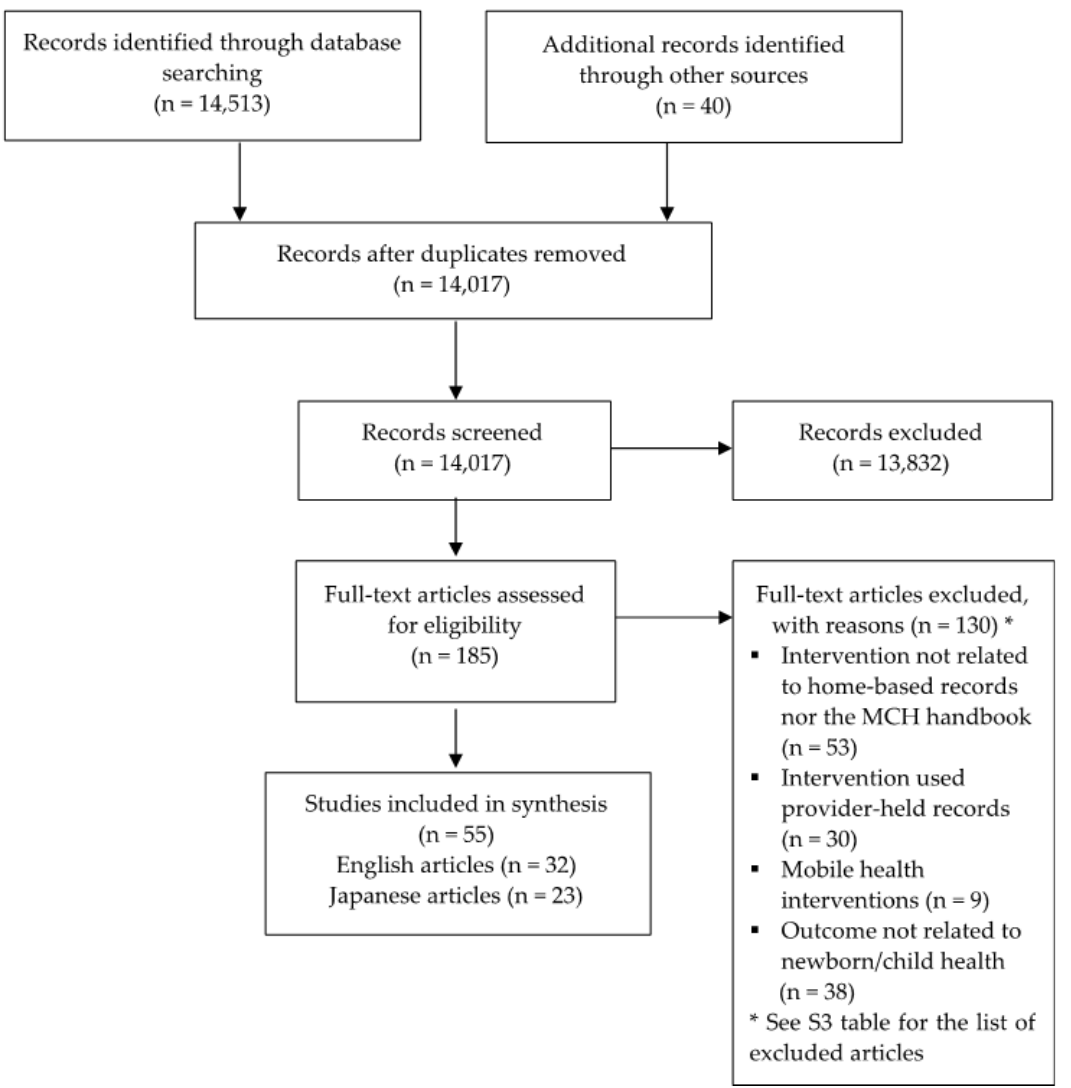
Figure 1. PRISMA flow diagram of the screening process.